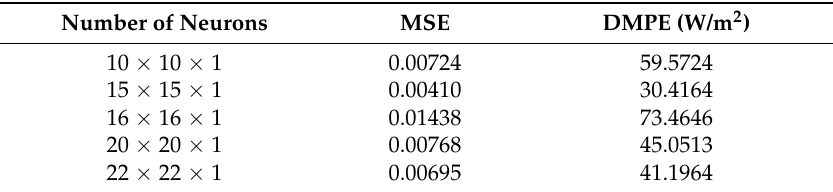
Table 5. Choice of the neurons number in the different layers.